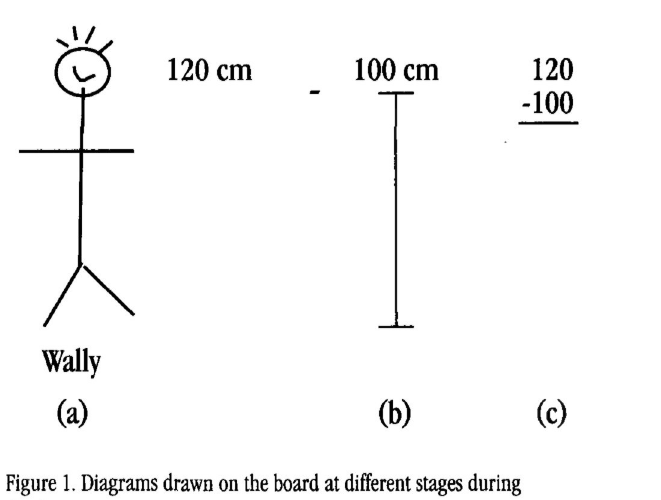
Figure 1. Diagrams drawn on the board at different stages during the